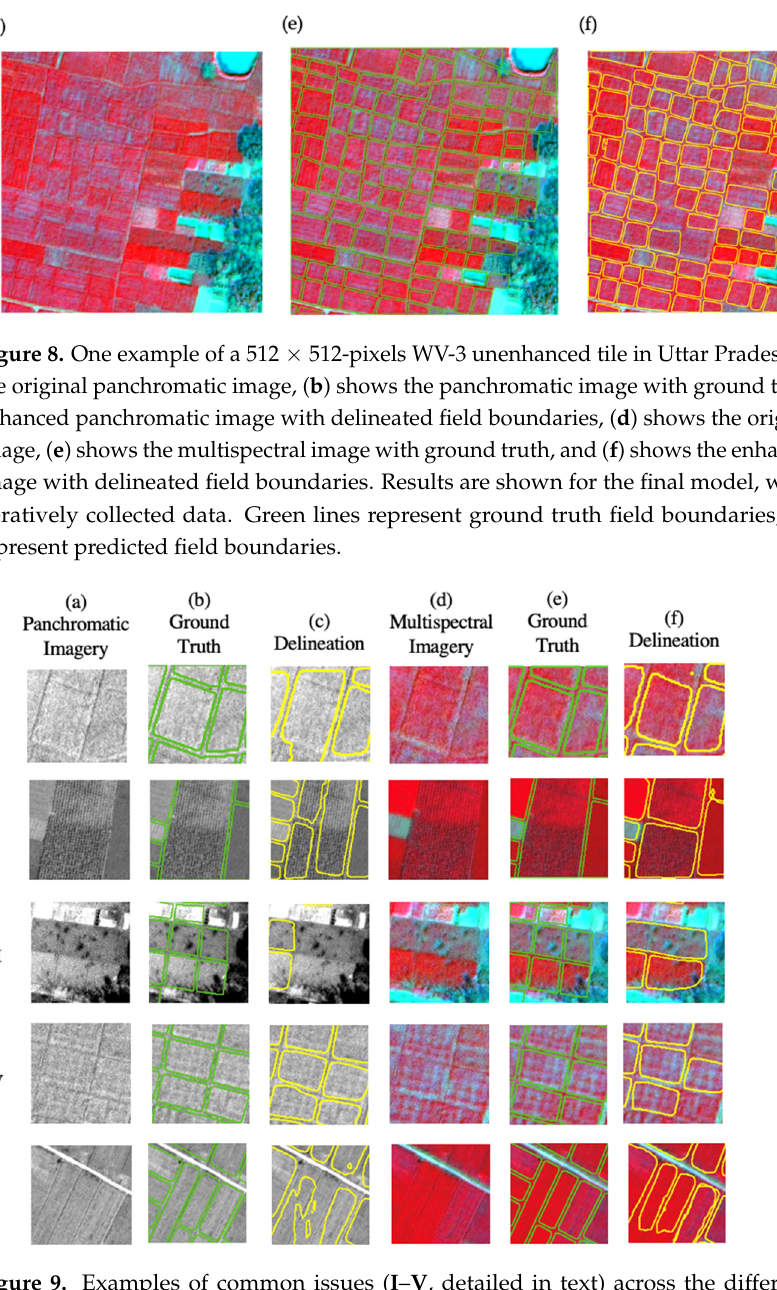
Figure 9. Examples of common issues ( I – V , detailed in text) across the different model results (panels ( a – f )) in Uttar Pradesh. Green lines represent ground truth field boundaries, and yellow lines represent predicted boundaries for panchromatic and multispectral imagery, respectively.